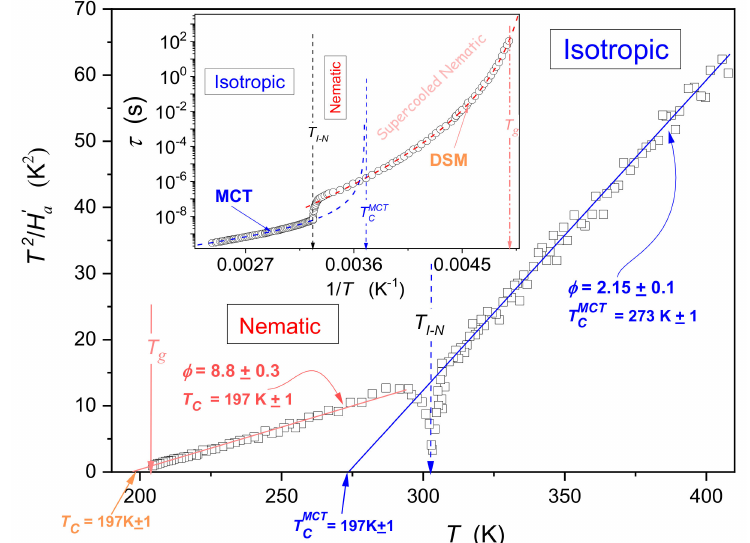
Figure 4. The evolution of the primary relaxation time in pentylcyanobiphenyl (5CB), from the isotropic liquid down to the glass temperature (the inset). The central part of the plot shows results of the distortions-sensitive analysis (Equation (14)) focused on the validity of the critical-like behavior (Equation (13)), indicated by linear domains. The linear regression fits yield parameters for Equation (13) given in the plot. They are used for portraying via Equation (13) τ ( T ) experimental data presented in the inset. The magnitude H (cid:48) a ( T ) = H a ( T ) / R is for the normalized apparent activation enthalpy. MCT means ‘mode-coupling theory’ [47,48], and ‘DSM’ is for the ‘Dynamical Scaling Model’ [49]. These models are developed for glass-forming liquids in the high- and low-temperature dynamical (cid:16) (cid:17) = 100 s T g domains. The glass temperature is estimated via the condition τ